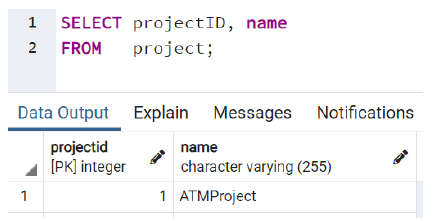
Figure A2. Query